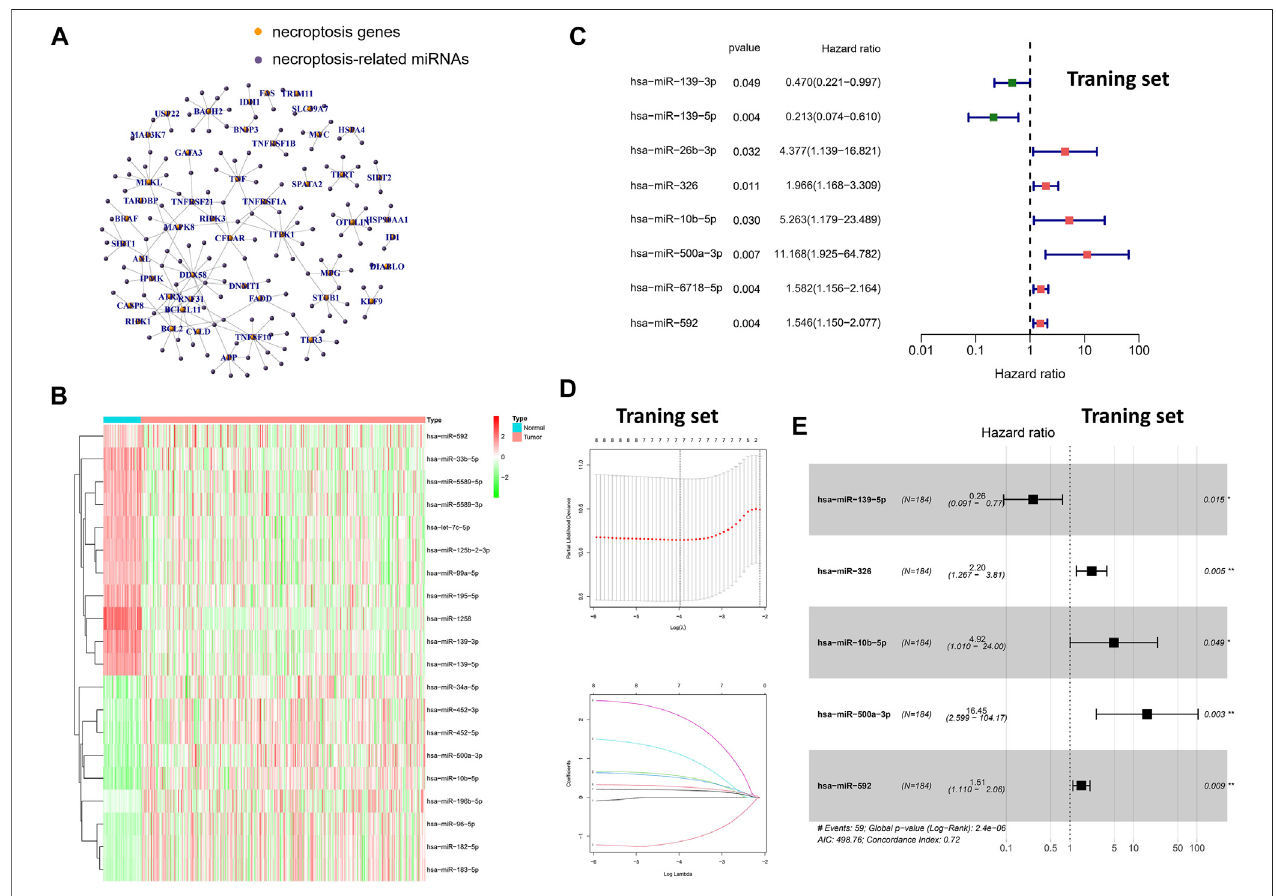
FIGURE 1 | Screening of speci fi c necroptosis-related miRNAs. (A) Pearson correlation analysis on 2435 miRNAs and 67 necroptosis-related genes. (B) The heatmap of DEms in different tissues samples. (C) Univariate Cox regression analysis of 35-miRNAs (only the 8 miRNAs with statistical signi fi cance were shown). (D) LASSO regression analysis. (E) Multivariate Cox regression analysis in 8 prognostic miRNAs.